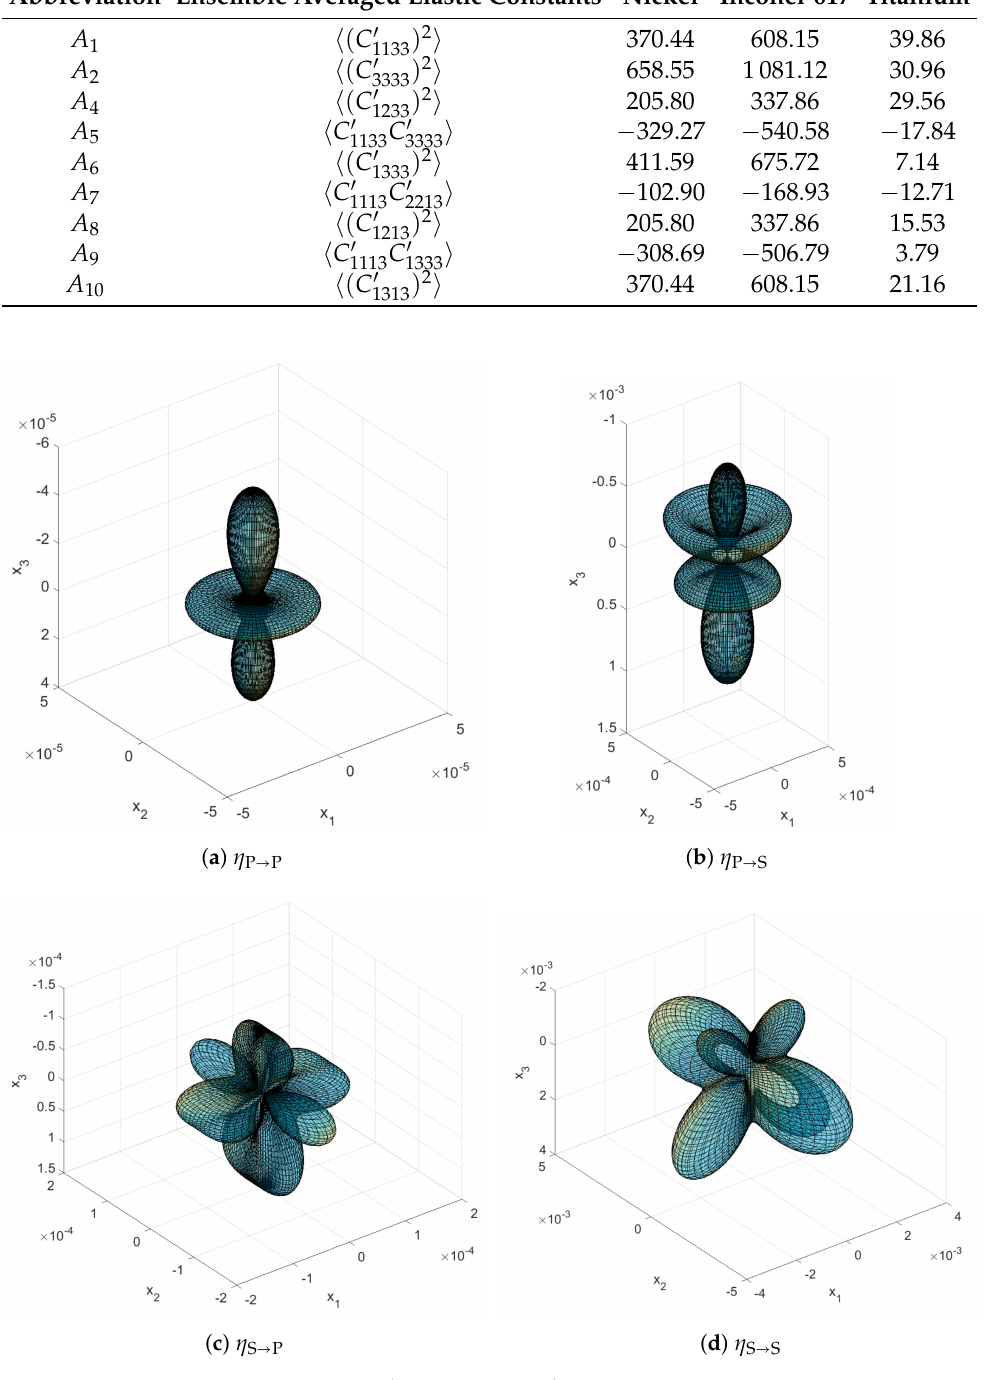
Figure 3. Spatial scattering functions η ( ϑ , ϕ ,2 π 10MHz ) for a single scatterer of size d eff = 54.5 µm in nickel. For every unit vector ( x 1 , x 2 , x 3 ) = ( sin ϑ cos ϕ , sin ϑ sin ϕ , cos ϑ ) , the function value η ( ϑ , ϕ ,2 π 10MHz ) is represented here as the length of the vector in the corresponding